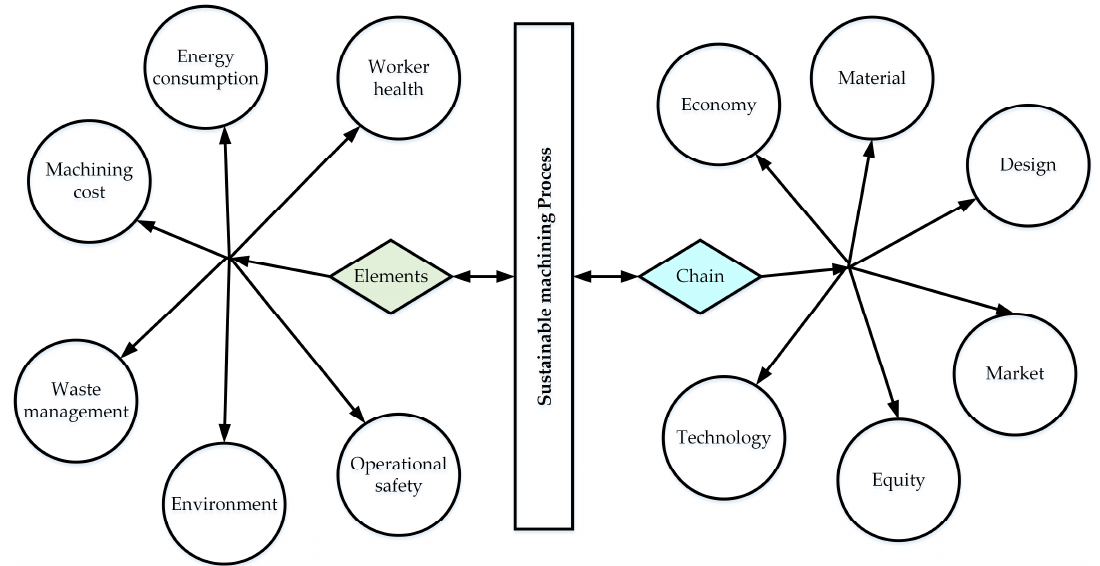
Figure 1. Fundamental elements of a sustainable machining process and the chain of product sustainability [6].